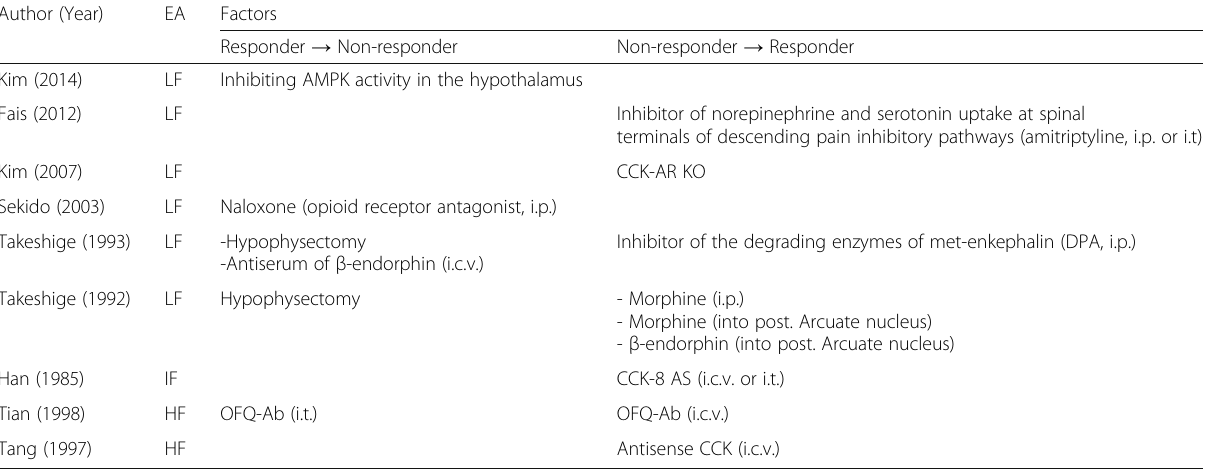
Table 5 Biological factors that convert the EA response from responder to non-responder or vice versa